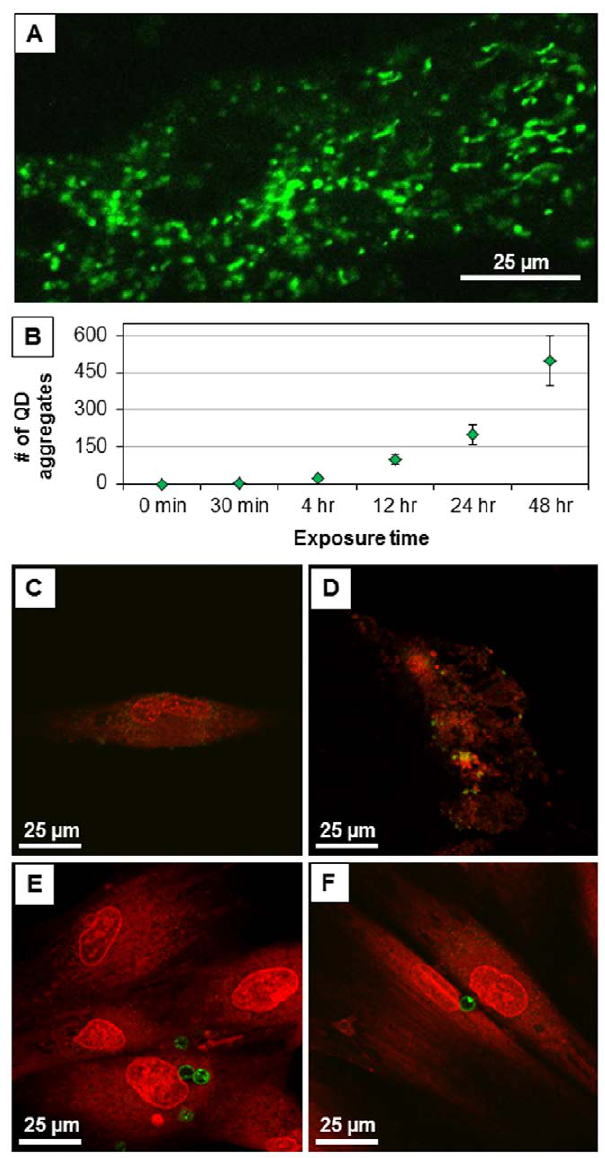
Figure 4. QD association and cellular morphology. (A) QD accumulation in HDF mitochondria (Confocal, 60 6 , Zeiss). (B) The number of QD aggregates accumulating in HDF increases over time. Fluorescence images of cells dosed with QDs at the (C) 12 hr and (D) 48 hr time points. Images of cells dosed with QDMCs (at an equivalent amount of Cd + 2 ions relative to QDs) at the (E) 12 hr and (F) 48 hr time points. Microcapsules are resting on top of cells, but do not enter cells. Cells dosed with an equivalent Cd atom concentration of the QD- loaded microcapsules displayed no evidence of particle uptake and remained viable with no sign of deterioration through the 48 hr time point.